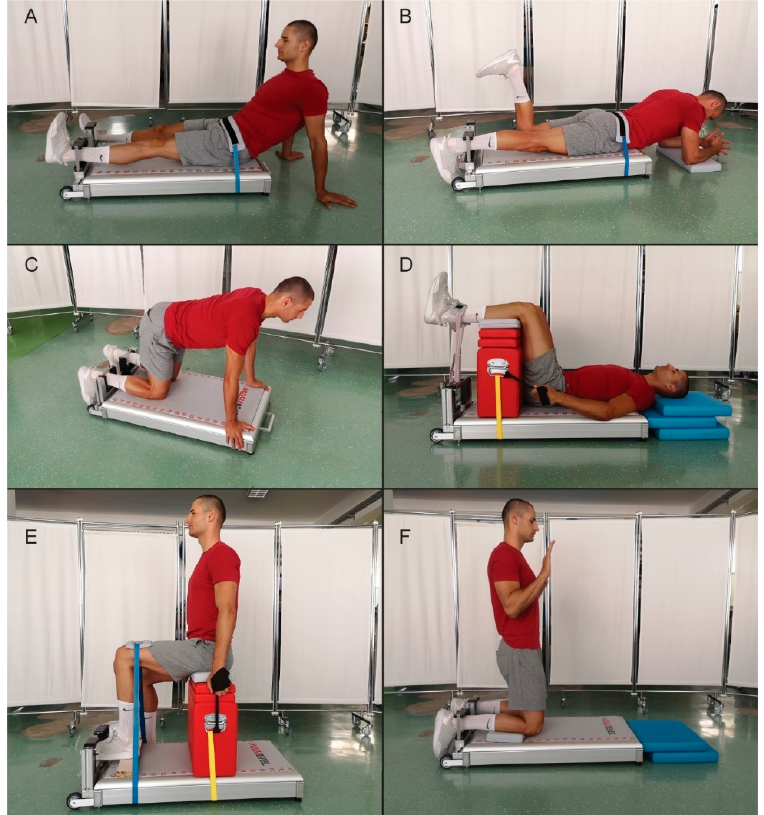
Figure 2. Test positions for measuring peak torque in hip, knee or ankle. ( A ) = hip flexion, abduction, and adduction; ( B ) = hip extension; ( C ) = hip internal and external rotation; ( D ) = knee extension; ( E ) = ankle plantarflexion; ( F ) = Nordic hamstring exercise.